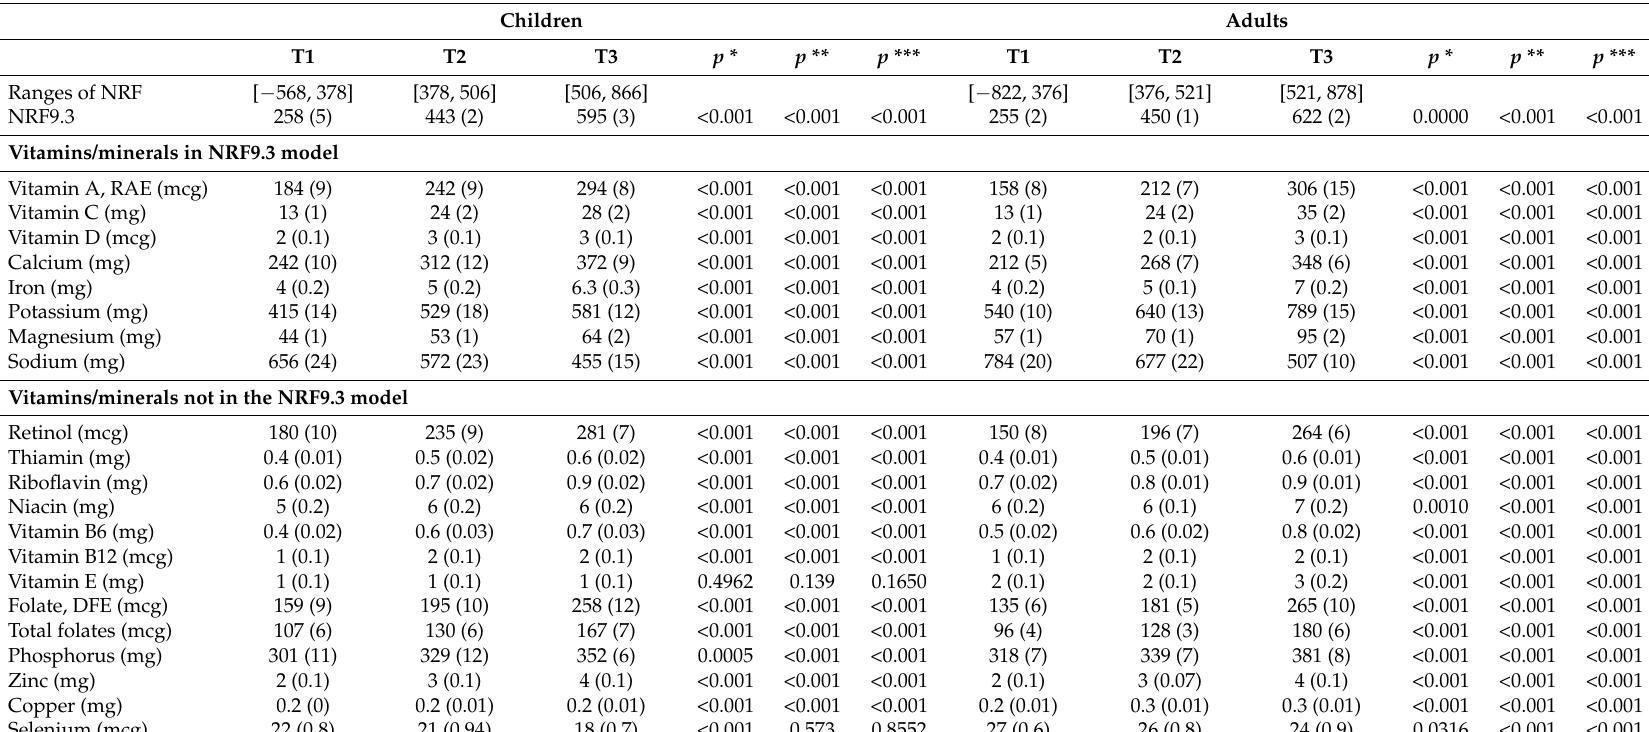
Table 4. Mean (standard error) intake of nutrients at breakfast (among consumers of breakfast only) across tertiles of NRF9.3 score by age